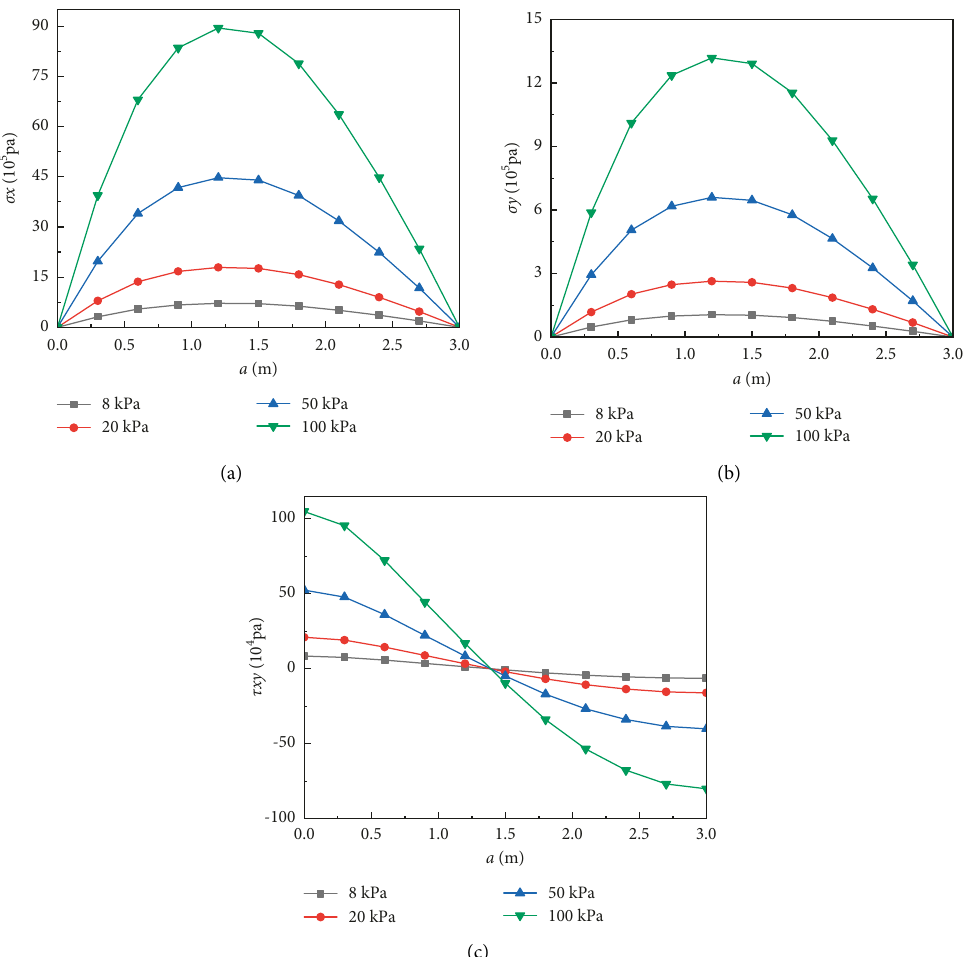
Figure 12: Effect of frost heaving force on stress.